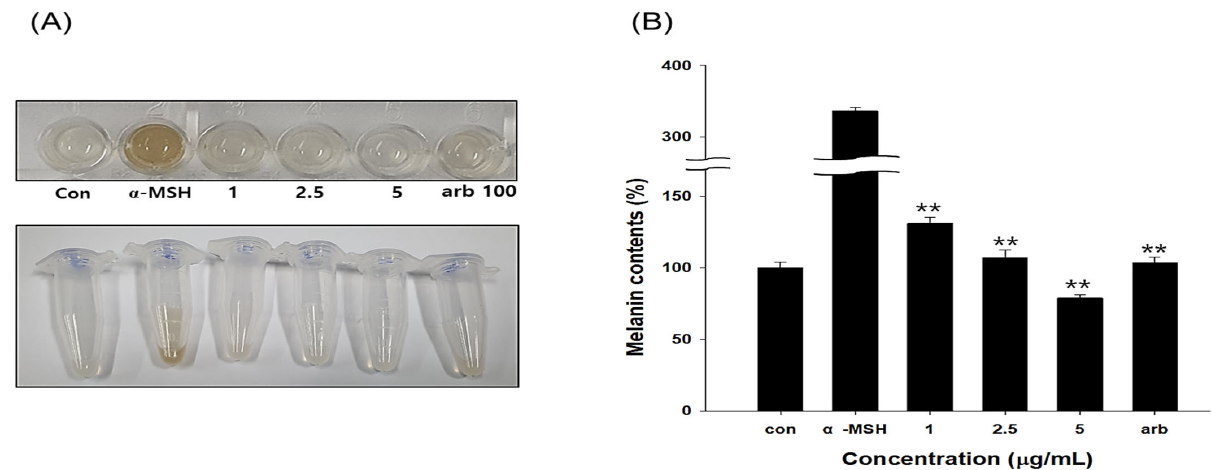
Figure 9. Measurement of melanin content in B16F10 melanoma cells treated with ethyl gallate. ( A ) B16F10 melanoma cells treated with ethyl gallate. The cells were cultured for 48 h in the presence of 1–5 μ g/mL (5.05–25.23 μ M) ethyl gallate as a positive control or 1 μ g/mL α‐ MSH. ( B ) Measurement of melanin content with 1–5 μ g/mL ethyl gallate (5.05–25.23 μ M). Relative melanin content was determined 72 h after treatment. n = 3, error bars, mean ± standard deviation. Effect of 100 μ g/mL arbutin (367 μ M) on melanin synthesis and tyrosinase activity in B16F10 cells. Significantly different compared with α‐ MSH, ** p < 0.01. α‐ MSH: α‐ melanocyte ‐ stimulating hormone.